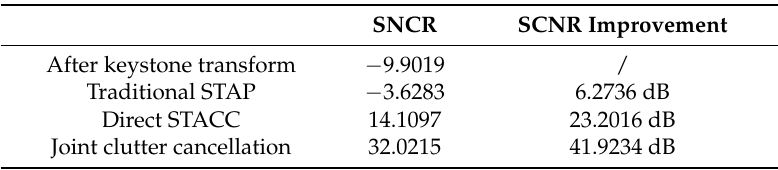
Table 2. SCNR Improvement of three